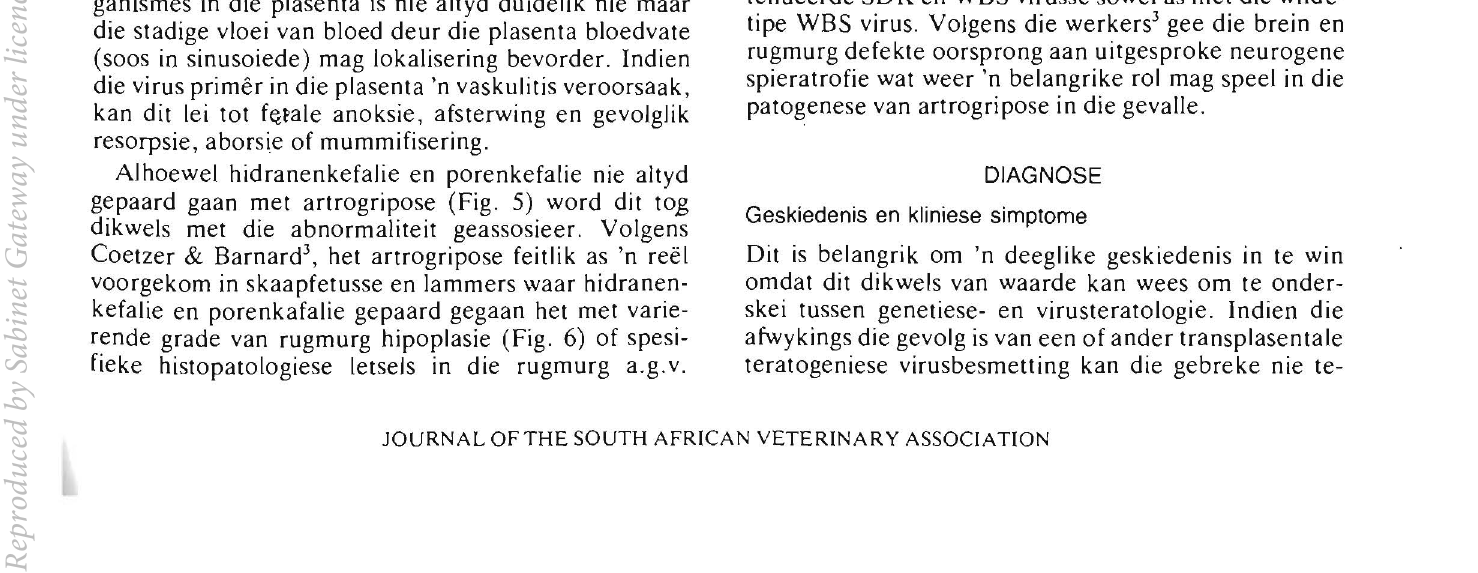
transplasentale besmettings met die muisbrein geat tenueerde SDK en WBS virusse sowel as met die wilde tipe WBS virus. Volgens die werkers 3 gee die brein en rugmurg defekte oorsprong aan uitgesproke neurogene spieratrofie wat weer 'n belangrike rol mag speel in die patogenese van artrogripose in die